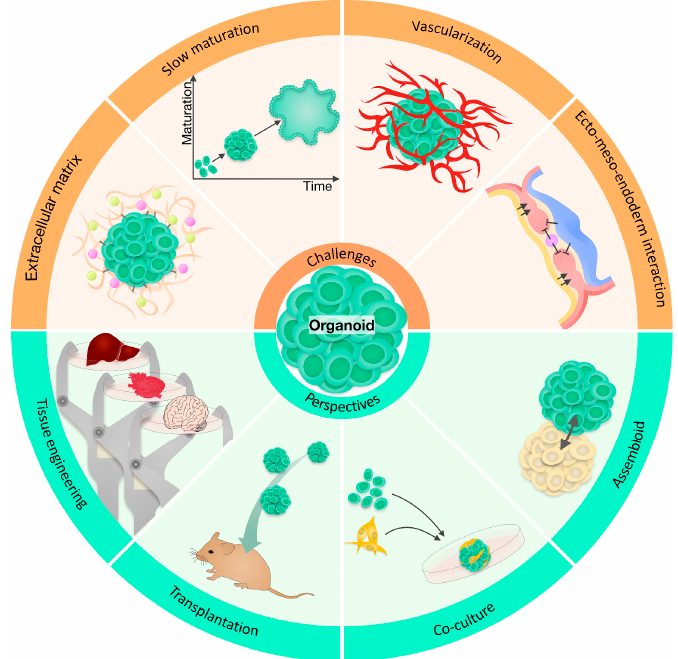
Figure 5. An overview of organoid challenges and perspectives. The schematic illustration repre- sents organoid technology challenges including slow maturation, lack of ECM, vascularization, and resents organoid technology challenges including slow maturation, lack of ECM,